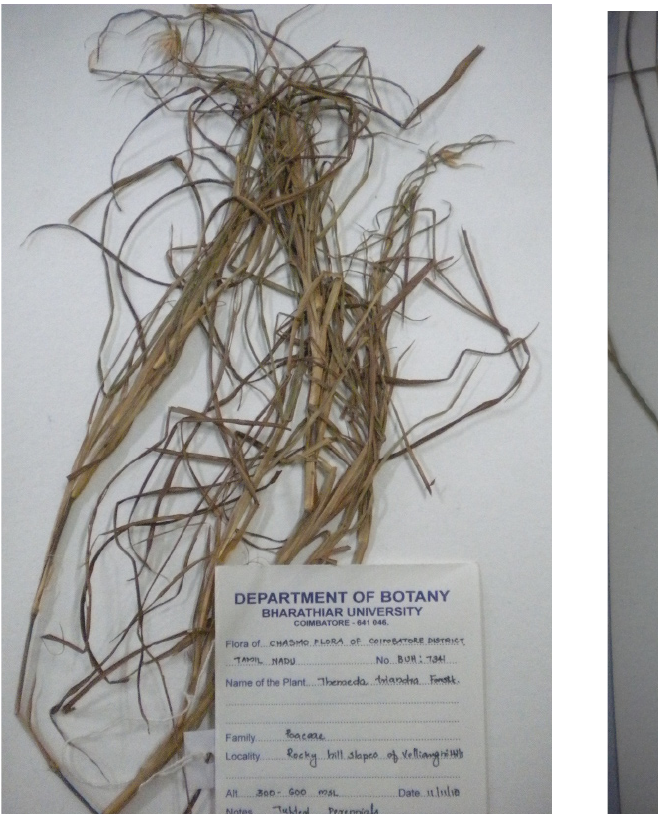
Image 34. Themeda triandra Forssk. Image 35. Zenkeria elegans